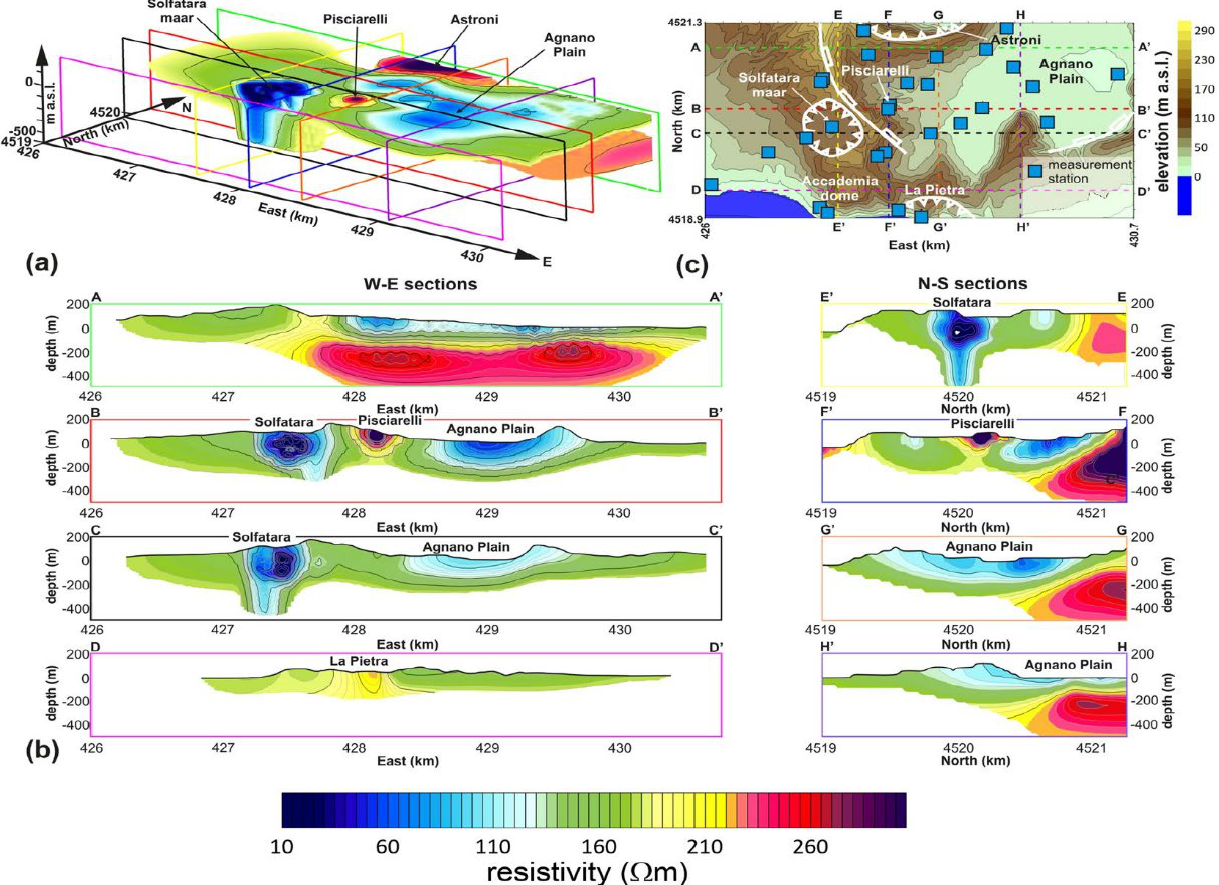
Figure 11. ( a ) Electrical resistivity 3D model obtained through the deep ERT imaging. ( b ) Electrical resistivity cross-sections along selected traces. ( c ) Map of the area resolved by the ER survey [42].